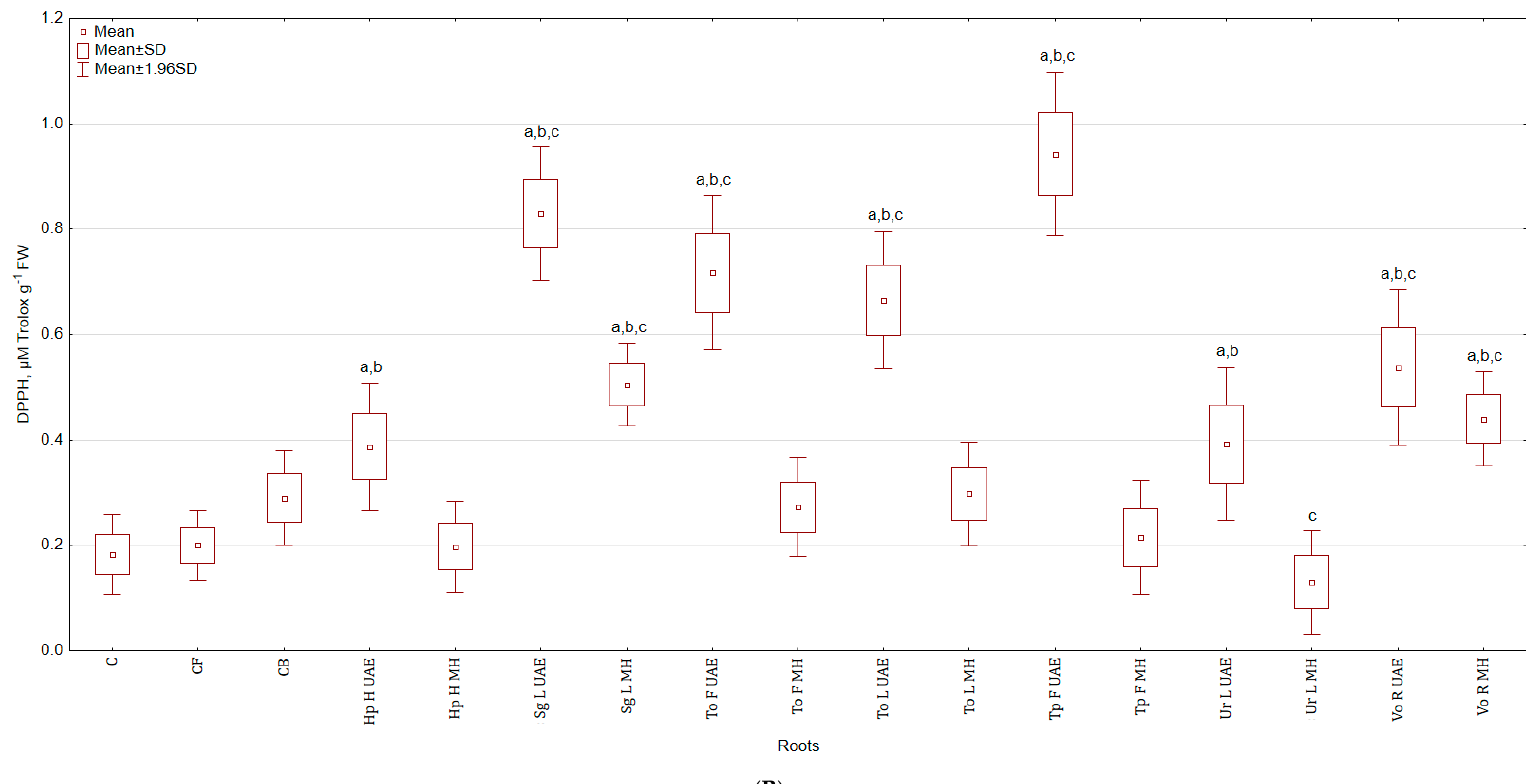
Figure 5. ( A ) Effect of the foliar application of botanical extracts on the antioxidant activity DPPH of celeriac leaves (N = 4). ( B ) Effect of the foliar application of botanical extracts on the antioxidant activity DPPH of celeriac roots (N = 4). (a) Statistically significant differences ( p < 0.05) between the control group (C) and extracts. (b) Statistically significant differences ( p < 0.05) between water formulation (CF) and extracts. (c) Statistically significant differences ( p < 0.05) between commercial biostimulant (CB) and extracts. 1st term of leaves rosette collection—samples taken for analyses 7 days after the second spraying. 2nd term of leaves rosette collection—samples taken for analyses after harvesting. Abbreviations: UAE, ultrasound assisted extraction; MH, mechanical homogenisation; Hp H, Hypericum perforatum L. (St. John’s wort, herb); Sg L, Solidago gigantea Ait. (giant goldenrod, leaf); To F, To L, Taraxacum officinale (L.) Weber ex F.H. Wigg (common dandelion, flower, leaf); Tp F, Trifolium pratense L. (red clover, flower); Ur L, Urtica dioica L. (nettle, leaf); Vo R, Valeriana officinalis L. (valerian, root).